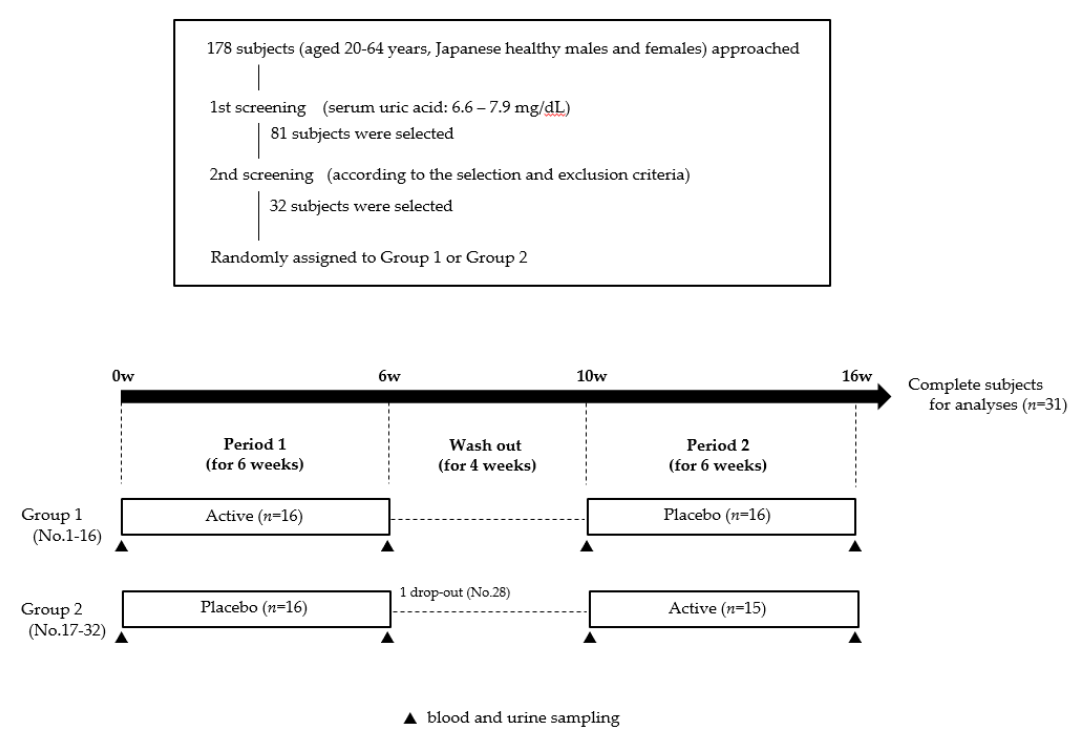
Figure 1. Experimental schedule showing the randomized, double-blind, placebo-controlled, crossover study design. The study was performed over a 16-week period.